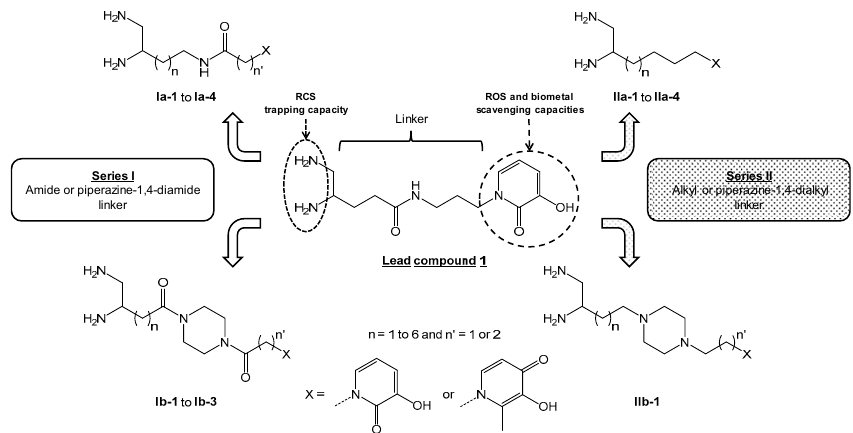
Figure 1. New pharmacomodulations on the linker of multifunctional advanced glycation endproducts (AGE)/advanced lipid peroxidation endproducts (ALE) inhibitor lead compound 1 .